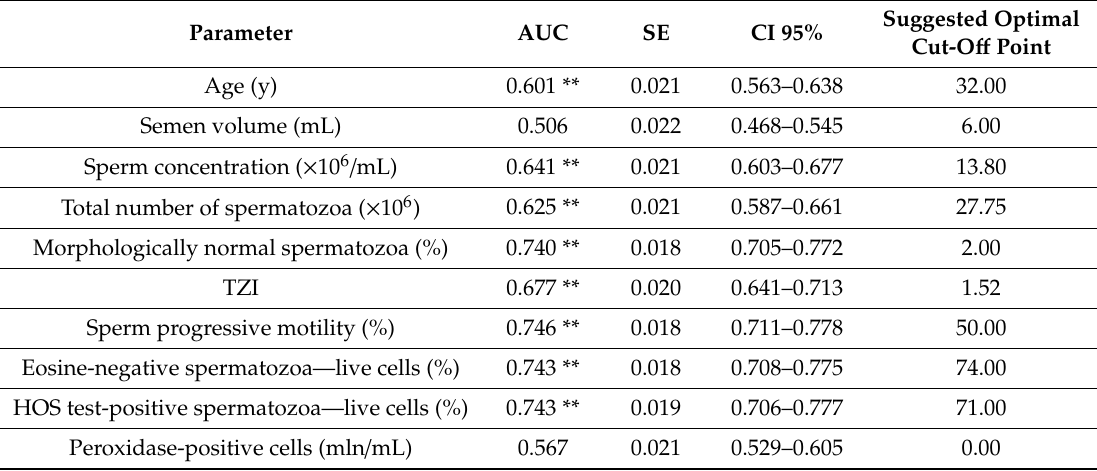
Table 4. ROC curve analysis for age and standard semen parameters. Criterion variable is SDF level >